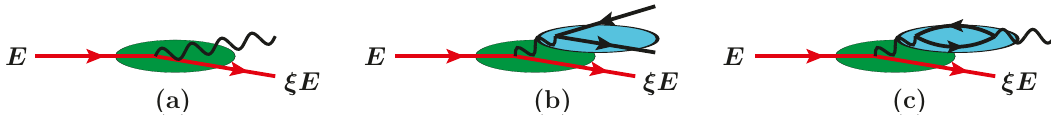
Figure 12 . Examples of processes which would contribute to the calculation of the di(cid:11)erential rate d (cid:0) =d(cid:24) at which a particle carrying a conserved charge (such as fermion number) degrades in energy: (a) leading-order bremsstrahlung; (b) the NLO e(cid:11)ect of a subsequent splitting that has an overlapping formation time with the bremsstrahlung; (c) a virtual correction to the leading- order bremsstrahlung (with overlapping formation time). In the case of large- N c QCD, the initial particle would be a quark (for study of charge deposition), but the particles in the real or virtual pair produced in (b) or (c) would be